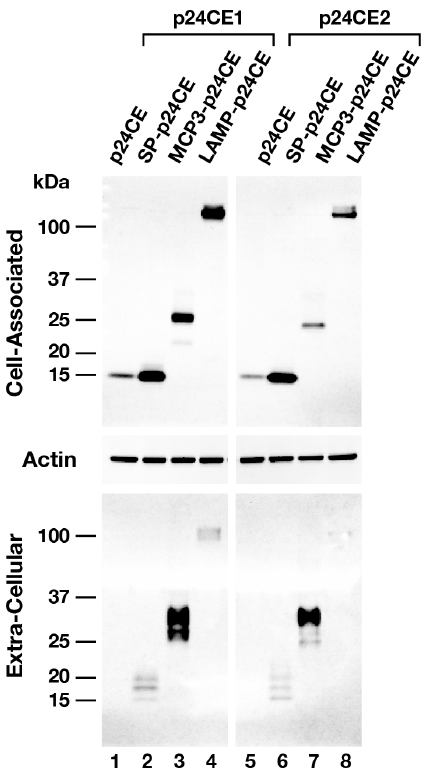
Figure 2. Expression of the p24CE plasmids upon transient transfection in cultured cells. Plasmid DNA (1 m g) expressing different variants of either p24CE1 (left panel) or p24CE2 (right panel) proteins were transfected in HEK293 cells. The cultures were harvested 24 hrs later and proteins from equal amounts (1/250) from the cell- associated (top panel) and extra-cellular (bottom panel) fractions were resolved on a 12% NuPAGE Bis-Tris gel and analyzed by Western immunoblot using a goat anti-p24 gag antiserum and visualized using enhanced ECL. The membrane containing the cell-associated fractions was also probed with anti-human pan actin antibody to control for equal loading of the samples.